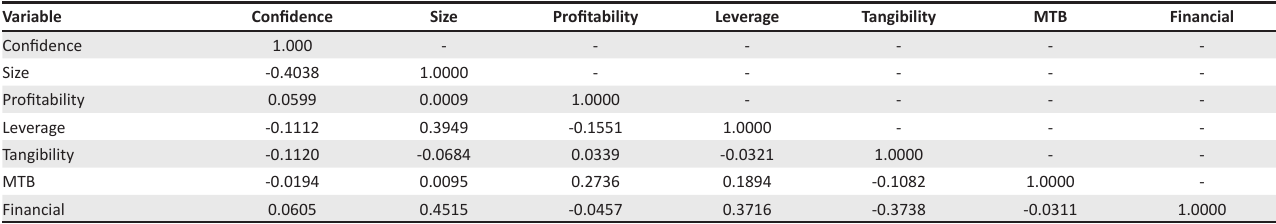
TABLE 3: Correlation